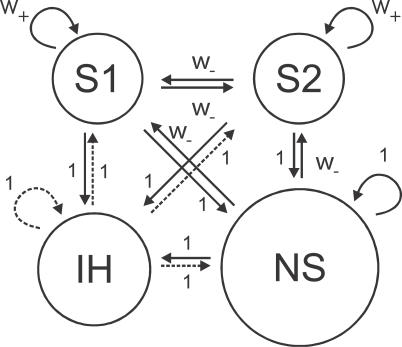
The Attractor Network ModelThe excitatory neurons are divided into two selective pools, S1 and S2 (with 40 neurons each), with strong intrapool connection strengths w+ and one nonselective pool (NS) (with 320 neurons). The other connection strengths are 1 or weak w
−. The network contains 500 neurons, of which 400 are in the excitatory pools and 100 are in the inhibitory pool IH. The network also receives inputs from 800 external neurons, and these neurons increase their firing rates to apply a stimulus or distractor to one of the pools S1 or S2. Protocol S1 contains the synaptic connection matrices.